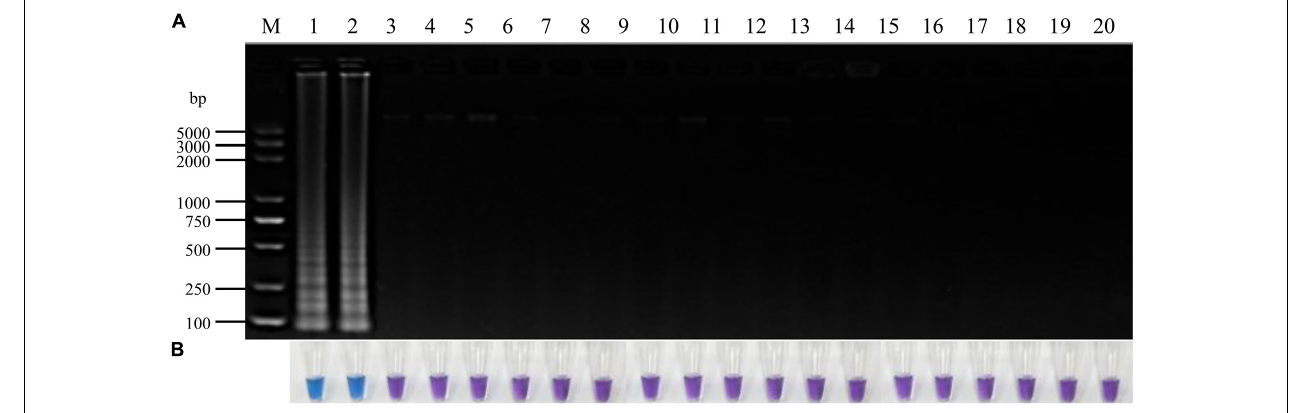
FIGURE 3 | Specificity of LAMP detection of P. vexans. (A) Detection of LAMP products by 2% agarose gel electrophoresis. (B) Detection of LAMP products detected by HNB, 1 and 2, P. vexans ; 3–20 indicate P. spinosum, P. irregulare, P. sylvaticum, P. helicoides, P. ultimum, P. myriotylum, P. litorale, P. oligandrum,